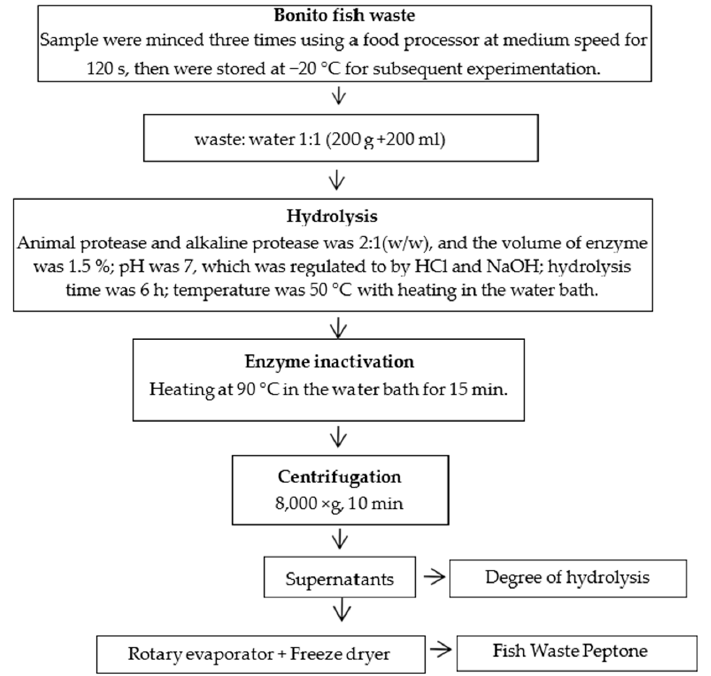
Figure 6. Flow chart of the enzyme hydrolysis in the laboratory.